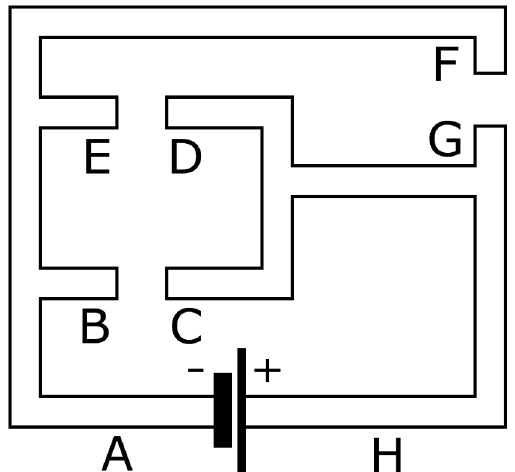
FIG. 6. Sample task designed to help students identify electric pressure differences in open circuits by using color